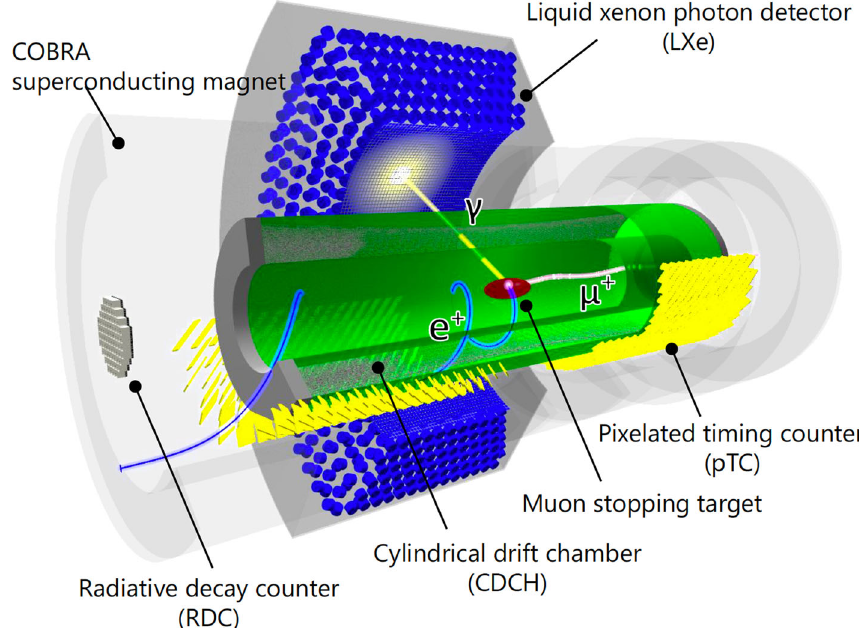
Fig. 7 MEGII experimental setup layout (3D view). An example of a μ + → e + γ decay event is